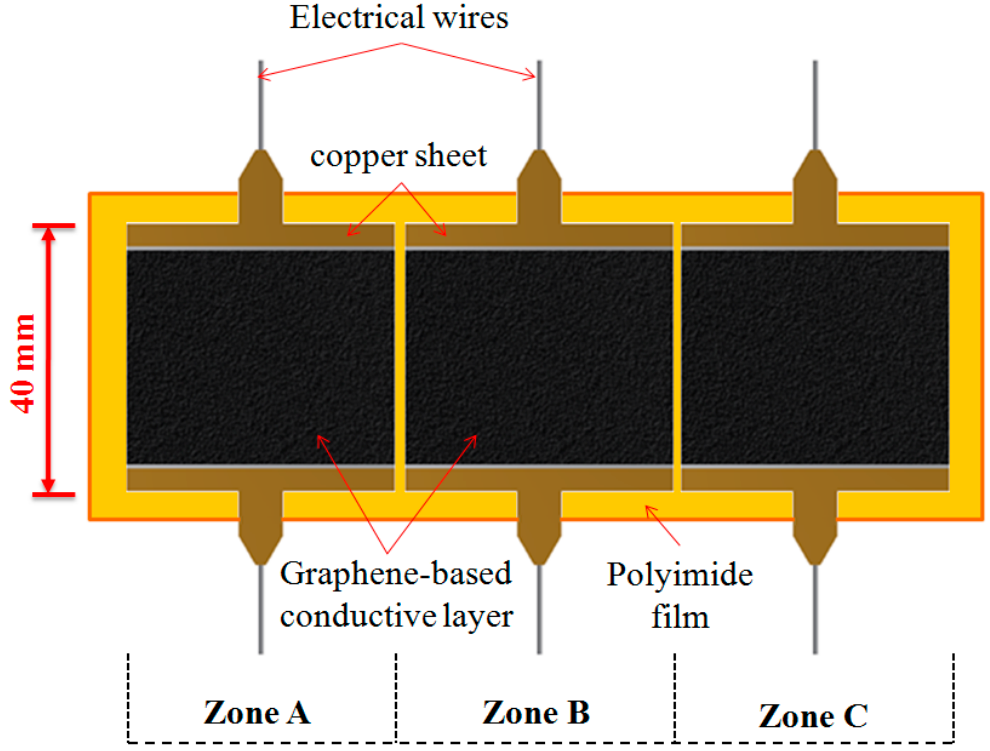
Figure 3. Design drawing and construction of the thin graphene-based heater with three heating zones.